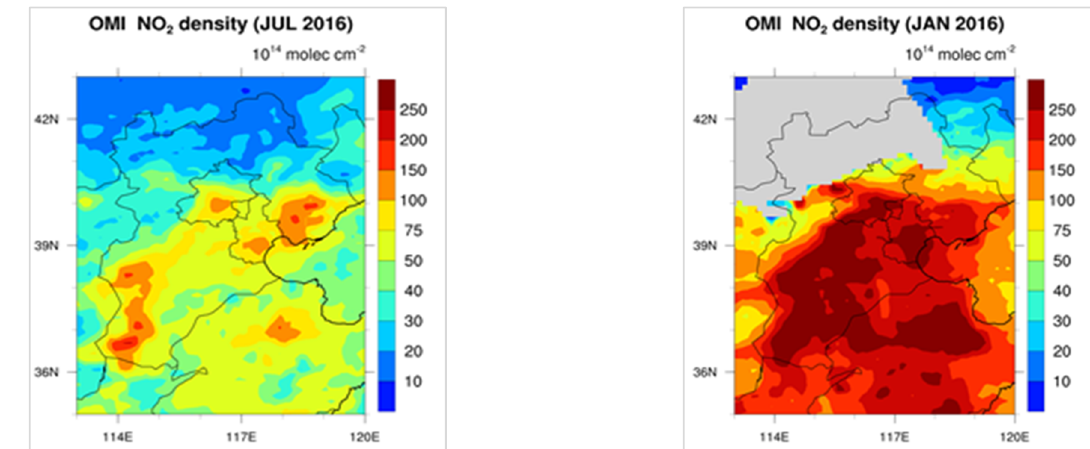
Figure 4. Spatial distributions based on satellite observation results of NO 2 concentration in January and July 2016 (molecular/cm 2 : the number of NO 2 molecules per square centimeter).